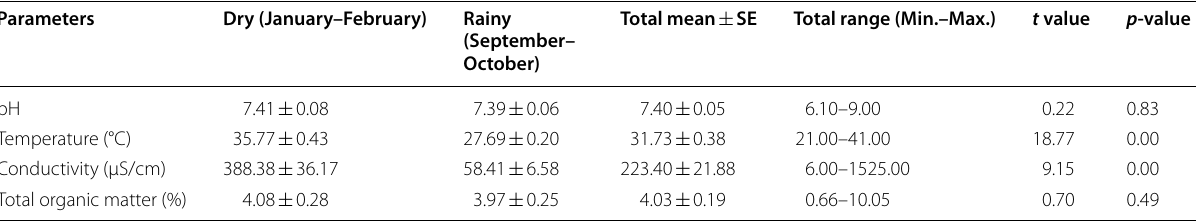
Table 1 Mean reading and range of soil physico‑chemical properties based on months of collection